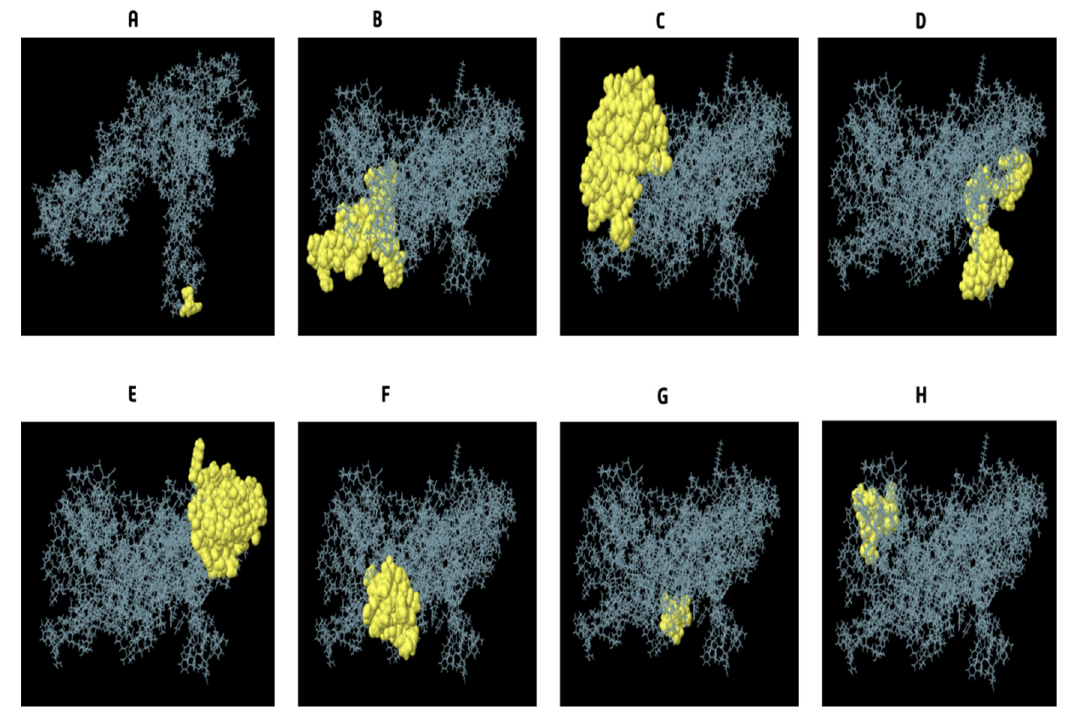
Figure 7. Dimensional display of conformational or discontinuous B-cell epitopes used in the epitope-based vaccine design. ( A – H ) Yellow surfaces show conformational or discontinuous B-cell epitopes, whereas grey sticks depict the rest of the polyprotein. Table 8. The conformational B-cell epitope residues of the planned epitope-based vaccination were predicted using ElliPro.